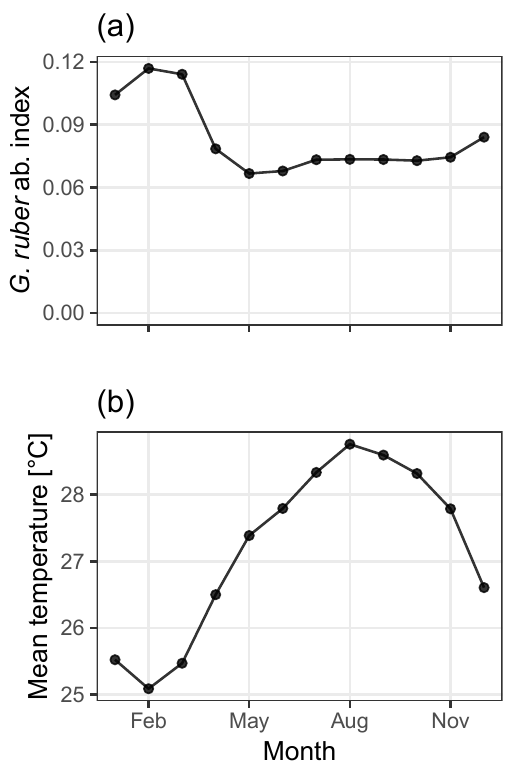
Figure 2. Abundance index of G. ruber from PLAFOM (Fraile et al., 2008) (a) , and the mean monthly sea surface temperature in the TraCE21ka simulation at MD97-2141 (b) . In this model, G. ruber occurs over the whole year with a small maximum during the cooler months of January–March, therefore biasing the recorded tempera- ture towards colder